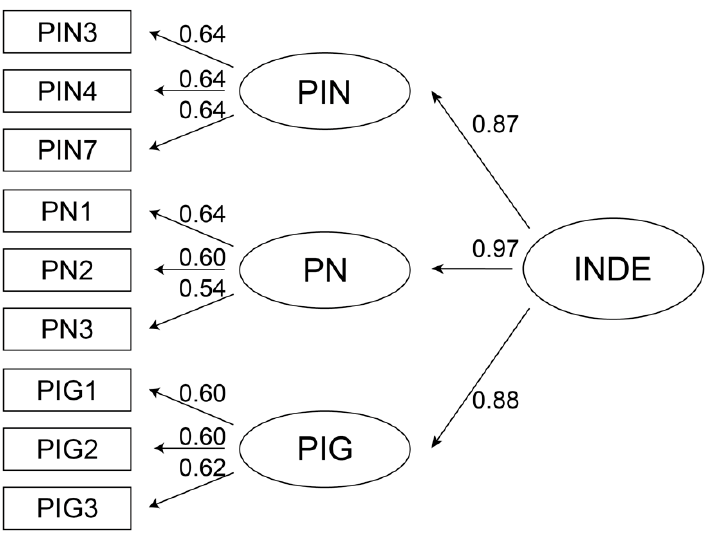
Figure 6. Second-order CFA Figure 5. Second-order CFA model.